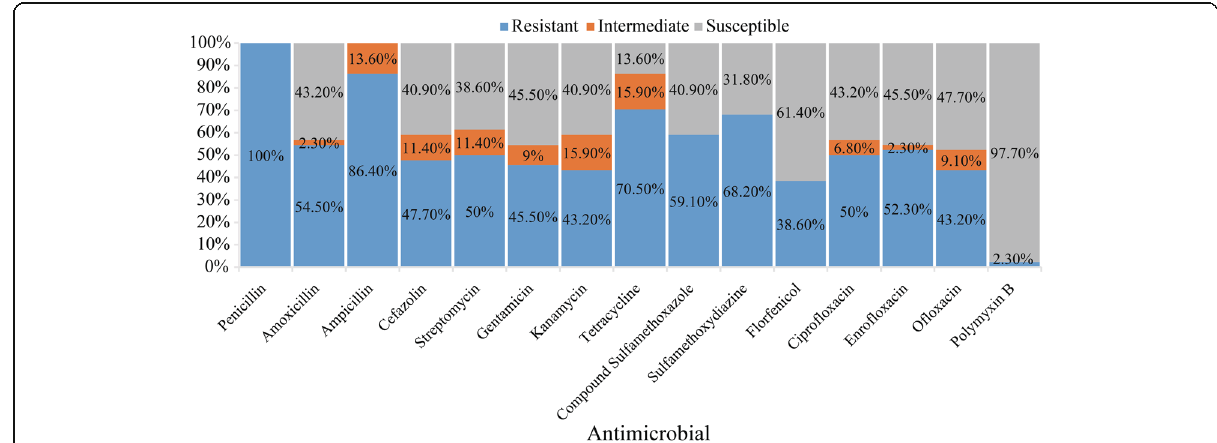
Fig. 2 Antimicrobial susceptibility profile to fifteen antimicrobials of E. coli isolates ( n = 44) from beef